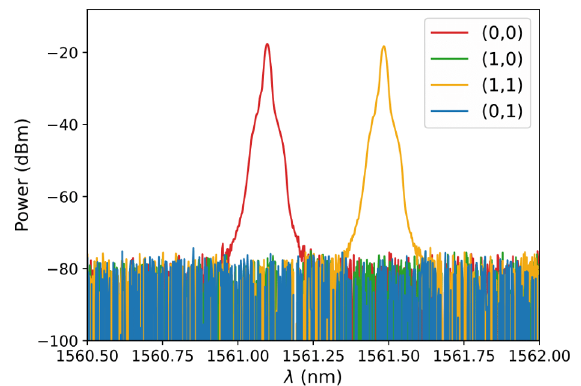
Fig. 2. Optical spectrum of the four states of the UFL-KDS